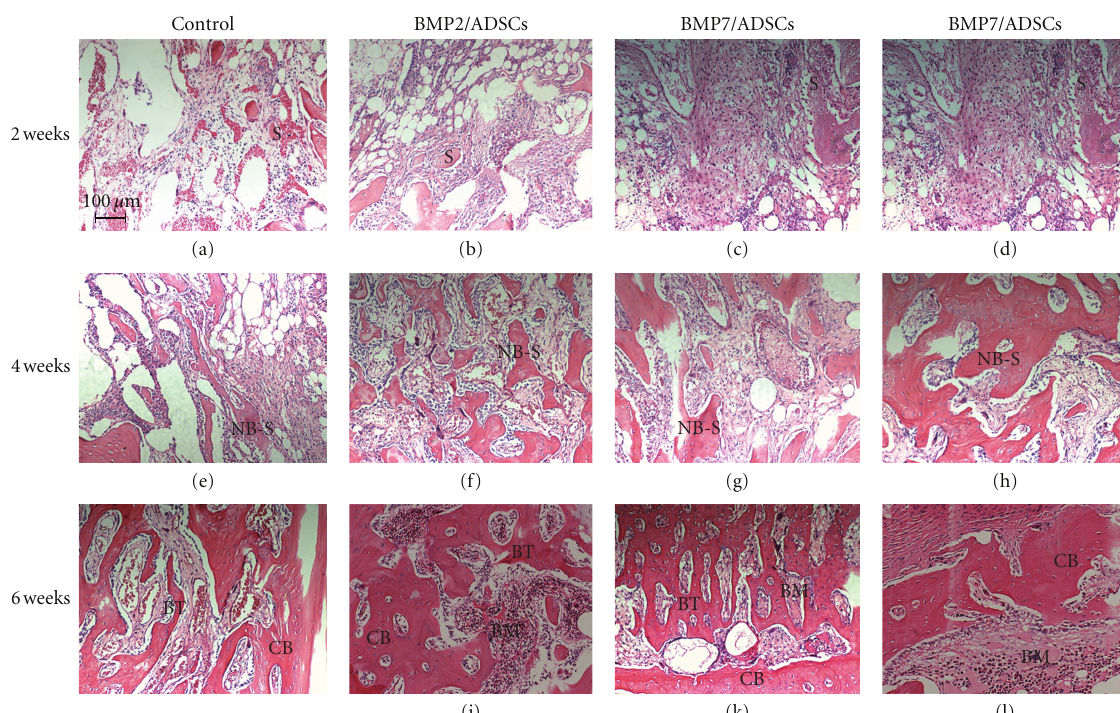
reaction disappeared in all groups. In BMP2/ADSCs